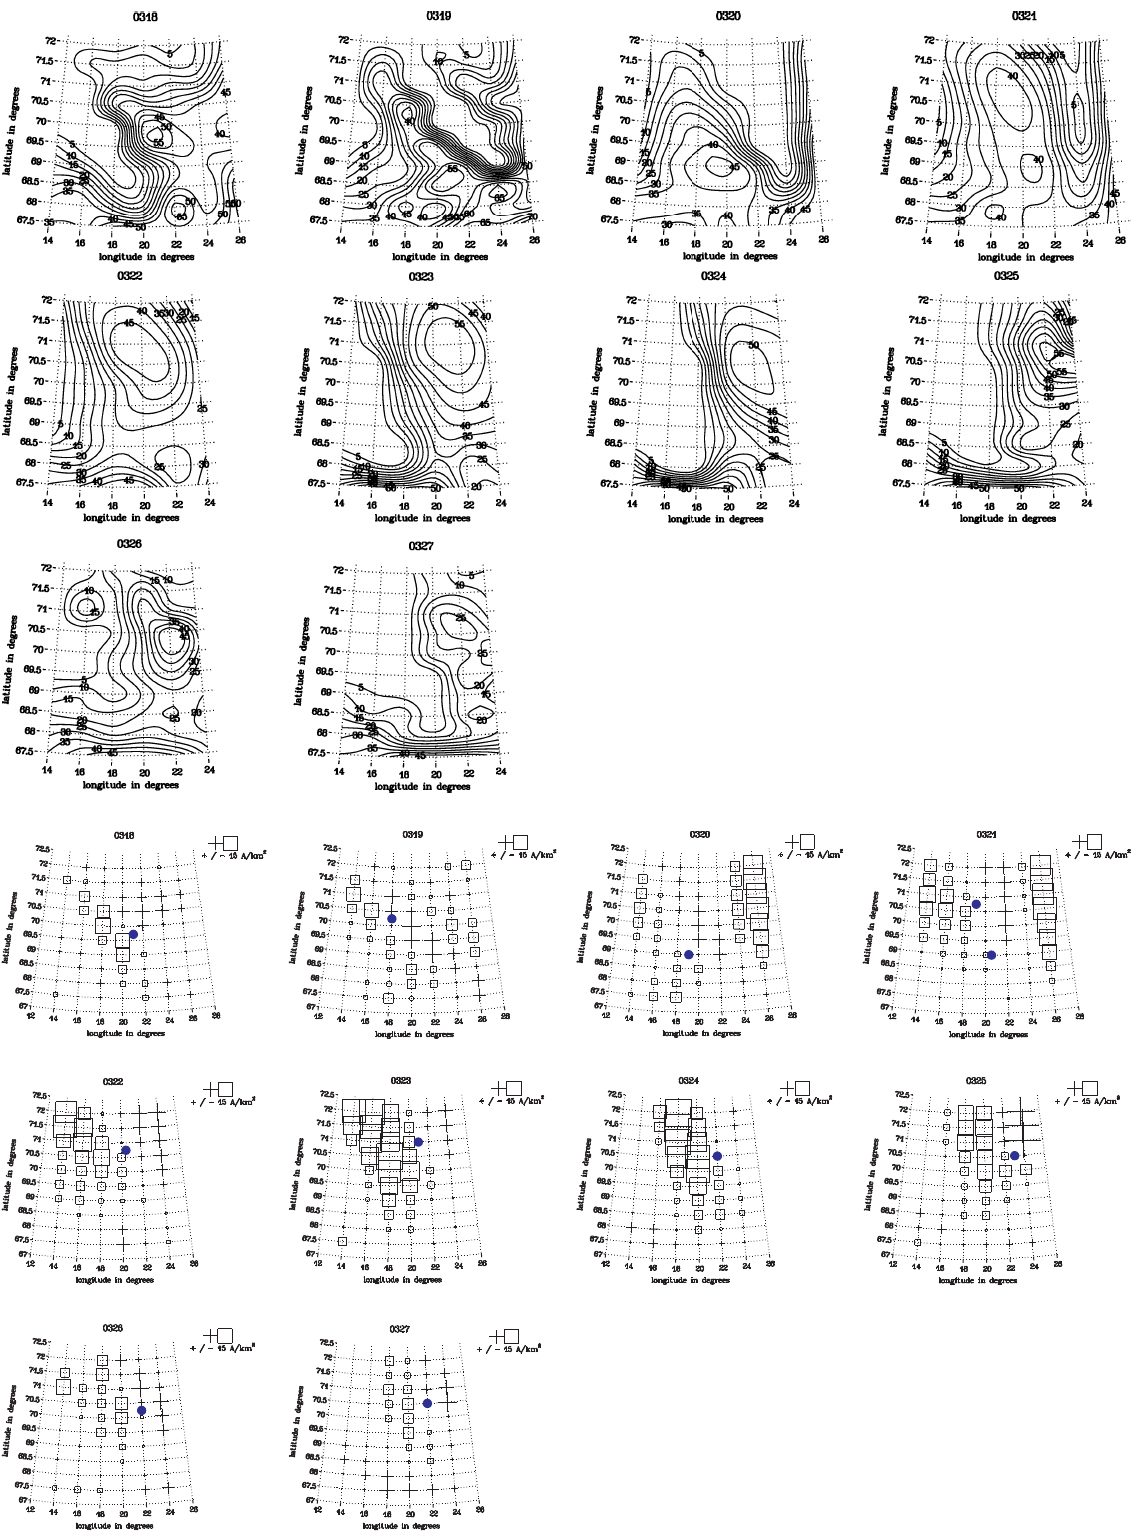
Fig. 7. Analysis results of the method of characteristics for an omega-band. Upper panel shows Hall conductance and lower panel field- aligned currents j k (crosses denote downward, squares upward currents; dots give the positions of isolated conductance maxima above 69 ◦ of latitude, cf. upper panel ). Reproduced from Fig. 6 of Amm et al.